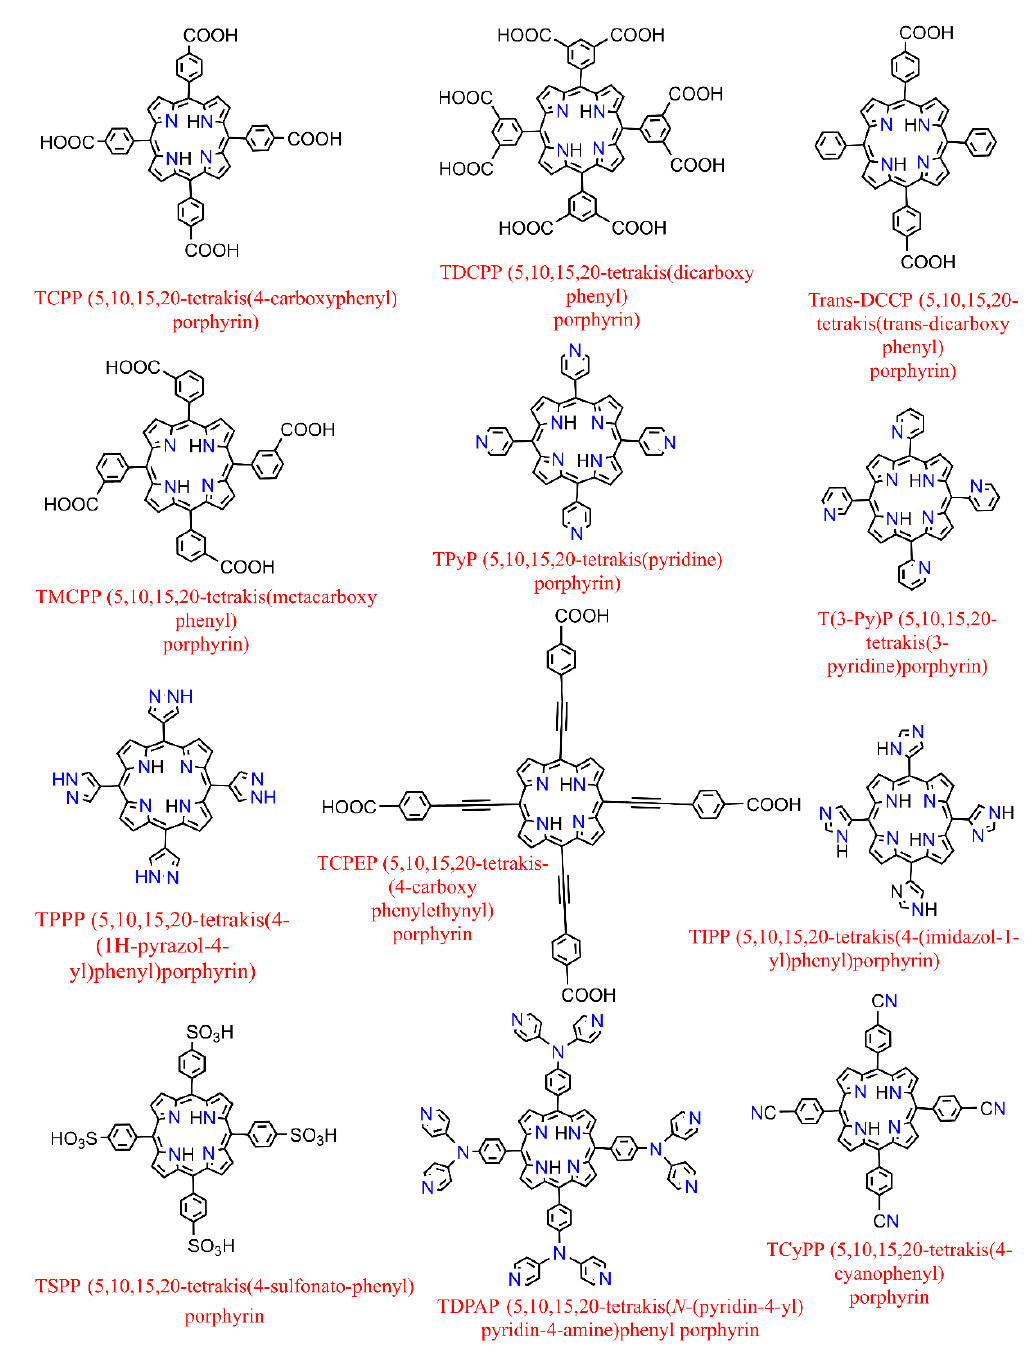
Figure 3. Examples of some of the previously fabricated porphyrin linkers.